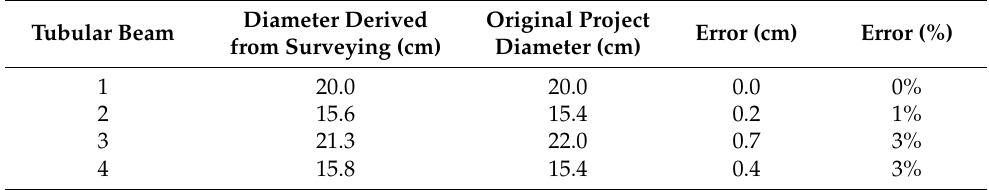
Table A2. Reconstruction error analysis of the spherical knots of the first mesh in terms of size (cm) and